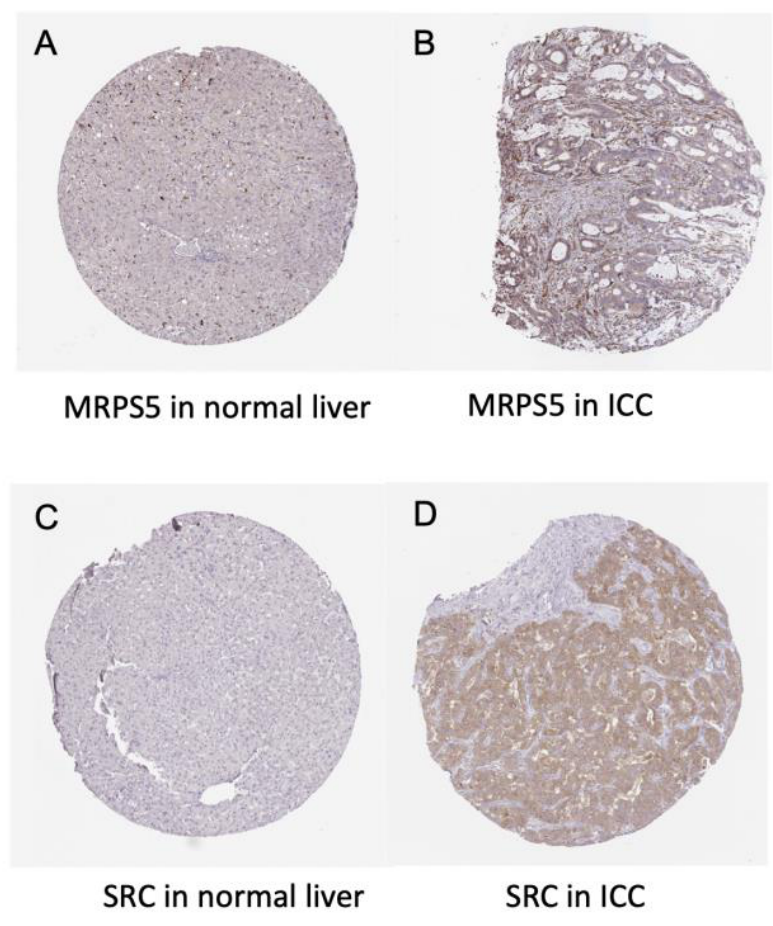
Figure 9. Immunohistochemistry of the MRPS5 and SRC genes in ICC and normal liver tissues. ( A ) MRPS5 in normal liver (cholangiocyte staining: not detected; intensity: negative; quantity: none). ( B ) MRPS5 in ICC (staining: low; intensity: weak; quantity: 75% – 25%; location: cytoplasmic and membranous). ( C ) SRC in normal liver (cholangiocyte staining: not detected; intensity: negative; Table 2. Candidate drugs and their mechanism of action identified via connectivity